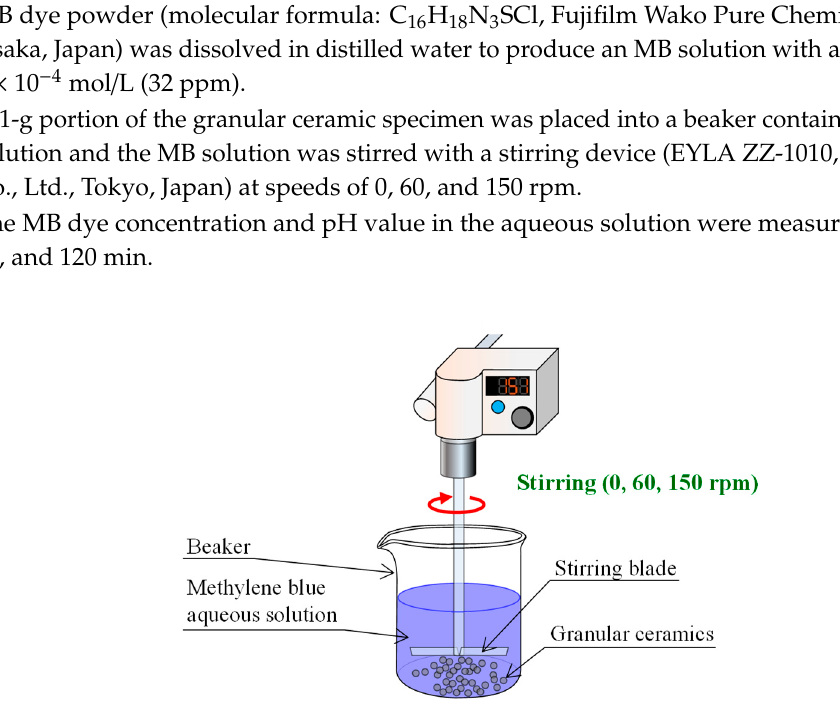
Figure 5. A schematic diagram of the MB dye adsorption test based on the granular GFRP/clay ceramic specimens.